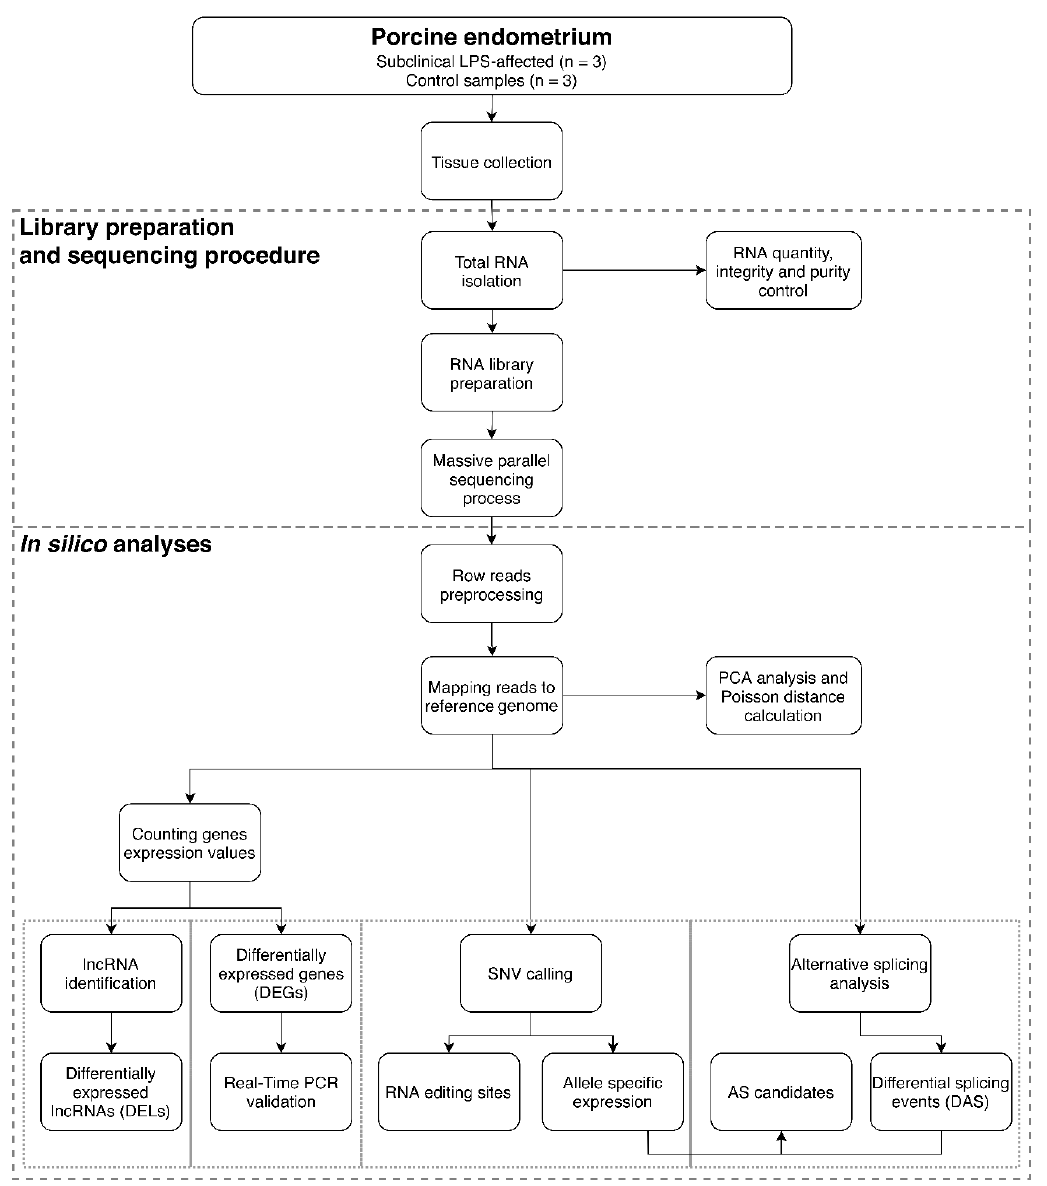
Figure 1. Flowchart of the RNA-seq wet-lab and in silico analyses. The main analytic pipeline contains: preprocessing quality control, mapping reads, biological replicates validation, differential genes and long noncoding RNAs (lncRNAs) expression analysis, alternative splicing events identification, allele-specific expression, RNA editing sites and real-time PCR validation. LPS—lipopolysaccharide; SNV—single nucleotide variant; AS—alternative splicing; PCA—principal component